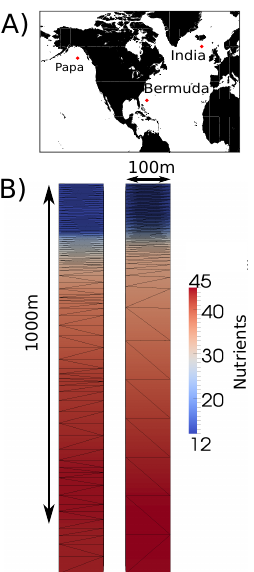
Fig. 1. Map of station locations (A) and 2-D view of the model domain at showing two different meshes produced by the adaptivity algorithm (B)